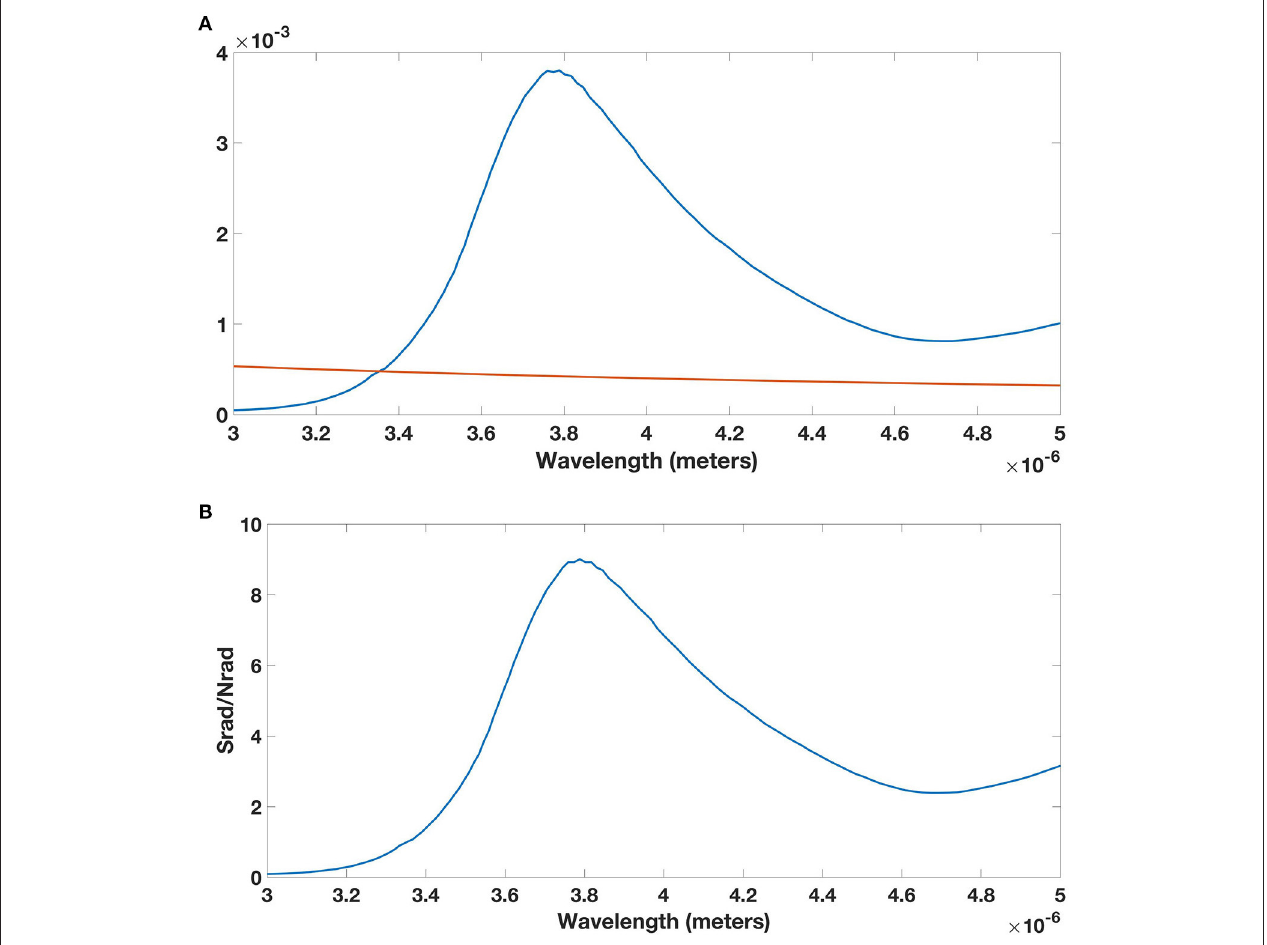
FIGURE 2 | (A) The signal (blue) obtained from Equation (12) with θ = 0, and the noise (red) from Equation (13). The signal was obtained using T 0 = 300K, 1 T = 1 K , and d = 1 mm , and using the optical depth data from Downing and Williams (1975). This represents heat flux from the water layer to the atmosphere of q = k 1 T d = 608 Wm − 2 , which is nearly equivalent to the heat flux obtained in experiments ( Handler and Smith, 2011) for a wind speed of about 3 ms − 1 . The noise was obtained for a sensor with a thermal resolution of 10 − 2 K . (B) The signal to noise ratio obtained from the results in (A)